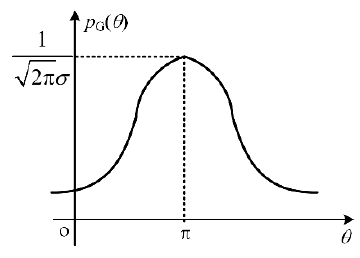
Figure 15. The Gaussian distribution of the multi-radiator phase.